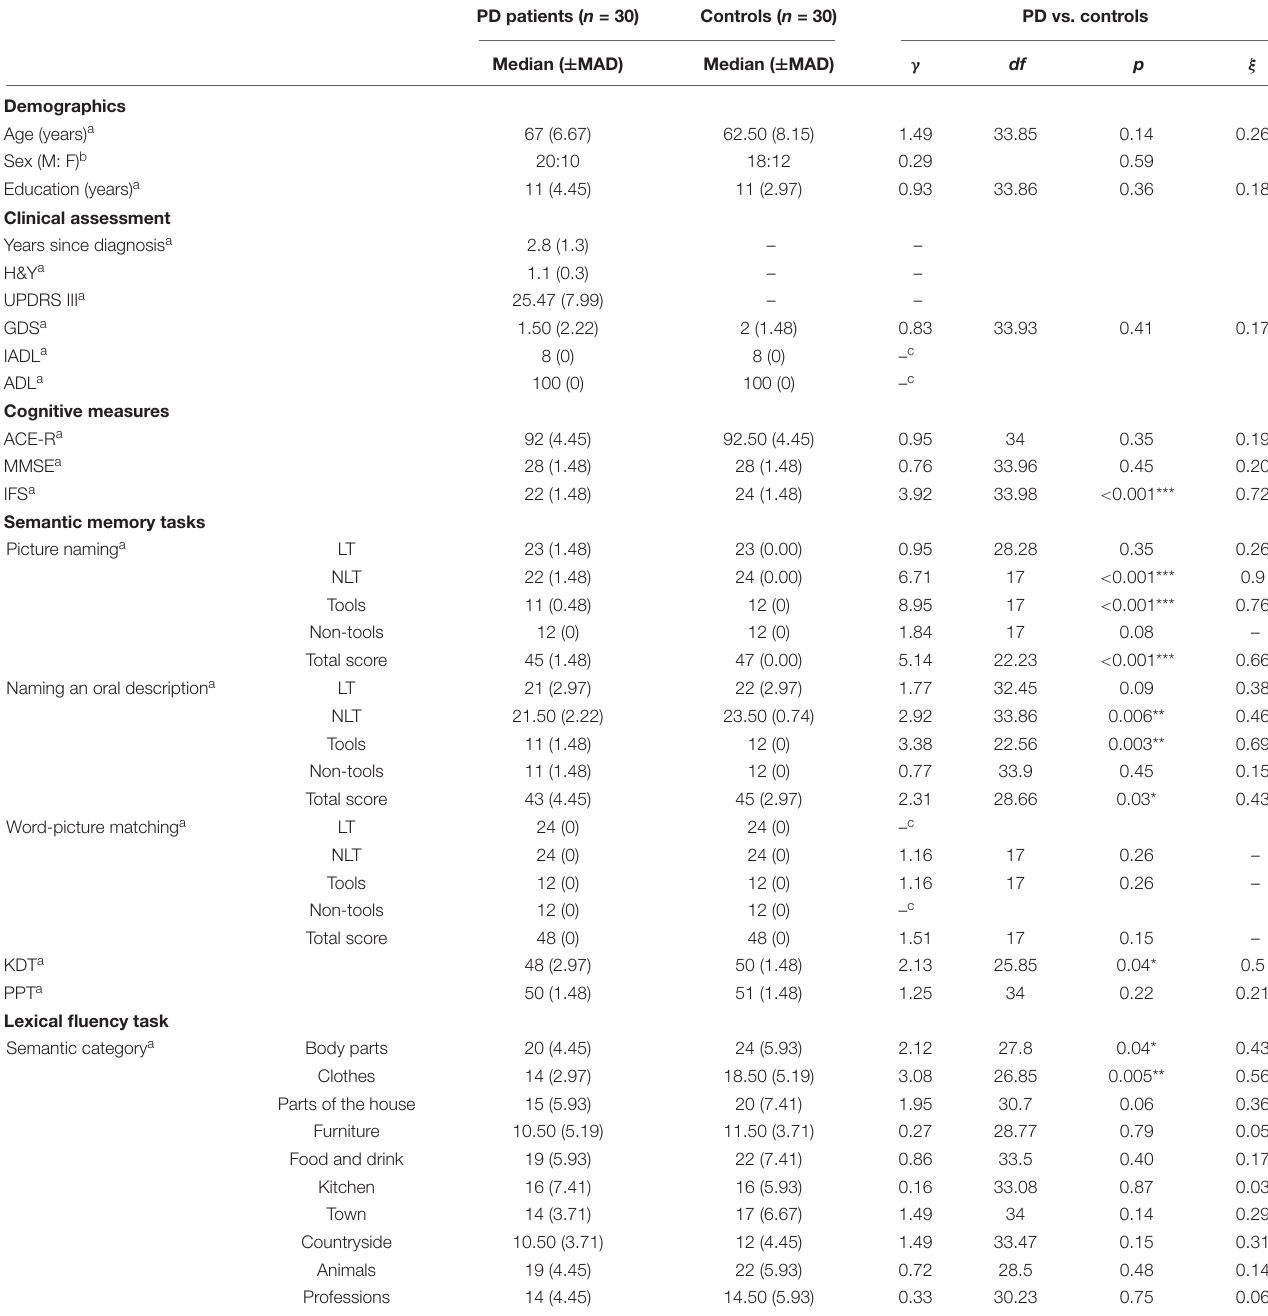
TABLE 1 | Demographic, clinical, and neuropsychological